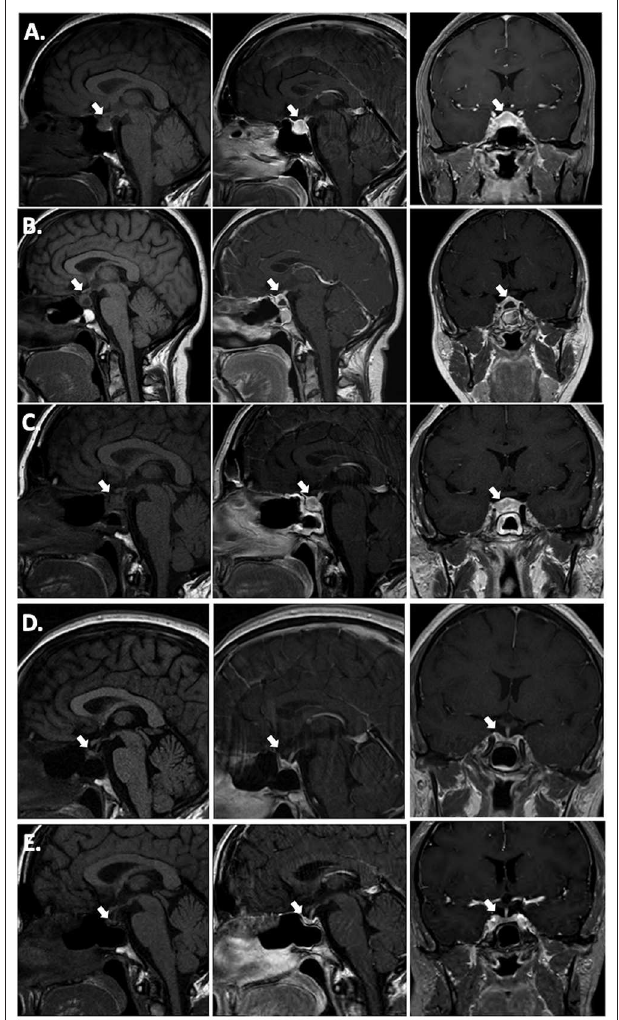
FIGURE 1 | T1 pre-contrast sagittal images (left column), T1 post-contrast sagittal images (center column) and T1 post-contrast coronal images (right column). (A) Pre-operative; (B) 2 weeks post-operative; (C) 15 weeks (3.5 months) post-operative, 3 weeks post-corticosteroid taper; (D) 26 weeks (6 months) post-operative, 12 weeks post-TNF- α inhibitor initiation (infliximab) immediately prior to azathioprine addition; (E) 17 months post-TNF- α inhibitor (infliximab combined with azathioprine for 15 months, followed by adalimumab combined with azathioprine).